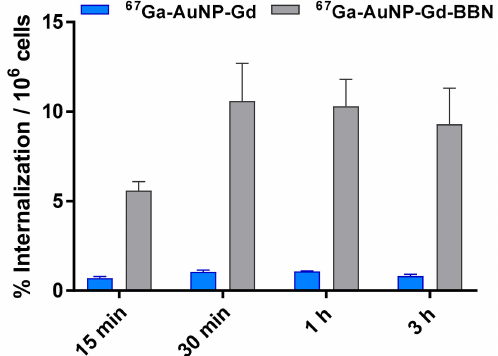
Figure 2. Cellular internalization studies of 67 Ga-AuNP-Gd and 67 Ga-AuNP-Gd-BBN in PC3 cells at 37 ◦ C at di ff erent incubation times, determined by γ -counting. Results are expressed as the percentage of the total radioactivity internalized by the cells (mean ± SD; n = 3) and normalized per million of